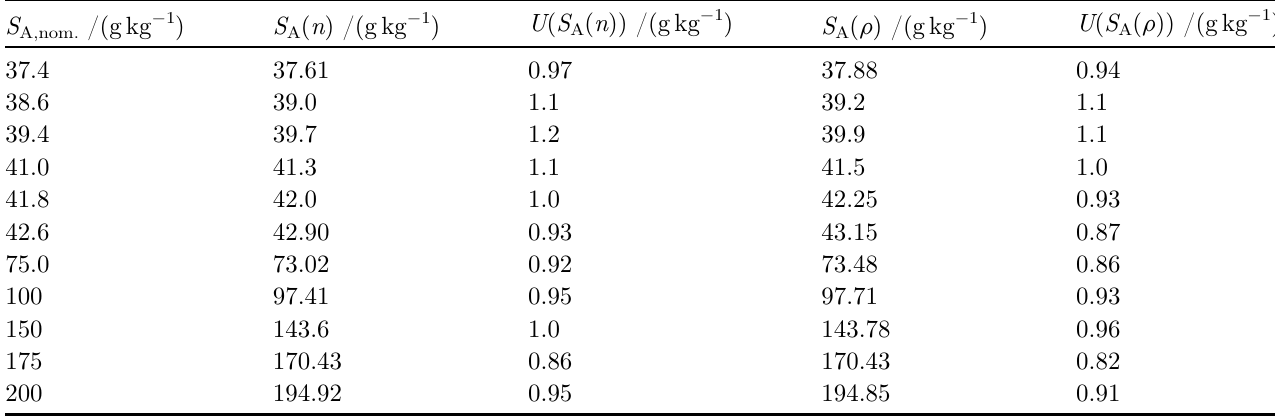
Table 3. Absolute salinity results of sodium chloride in OSIL SSW solutions obtained from refractive index, S ( r ), measured values and respective expanded uncertainties, U ( k = 2). density, S A S /(g kg (cid:1) 1 ) A,nom.